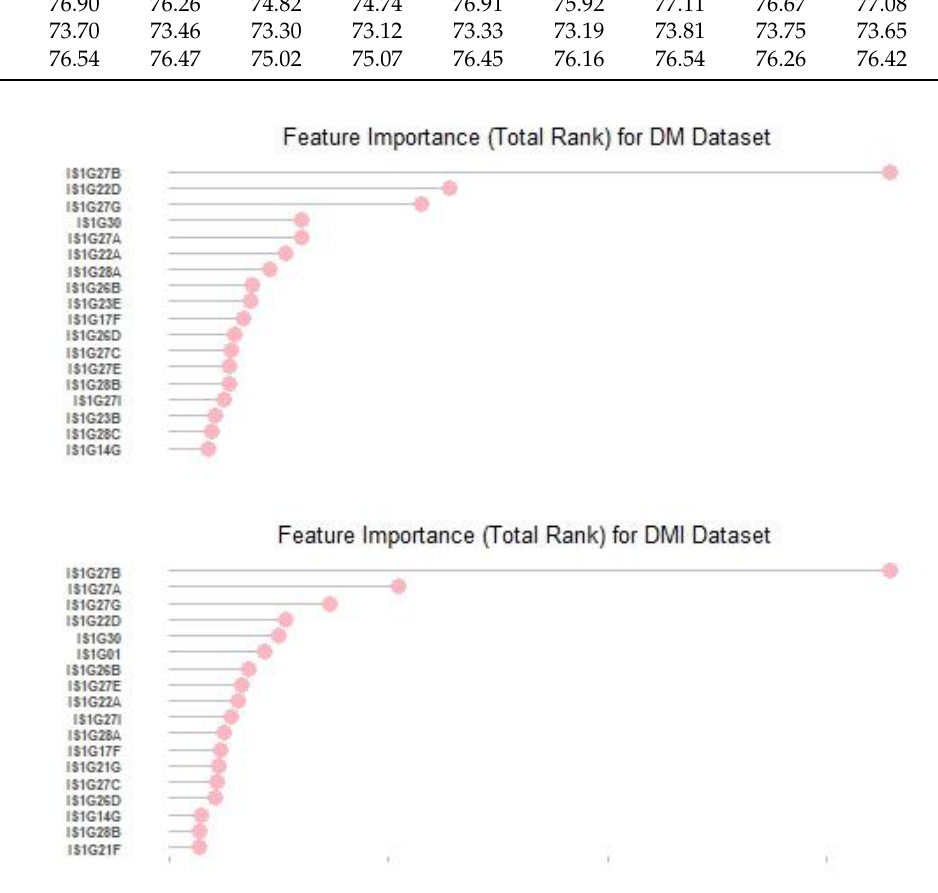
Table 3. Classification accuracy for the DMI dataset.